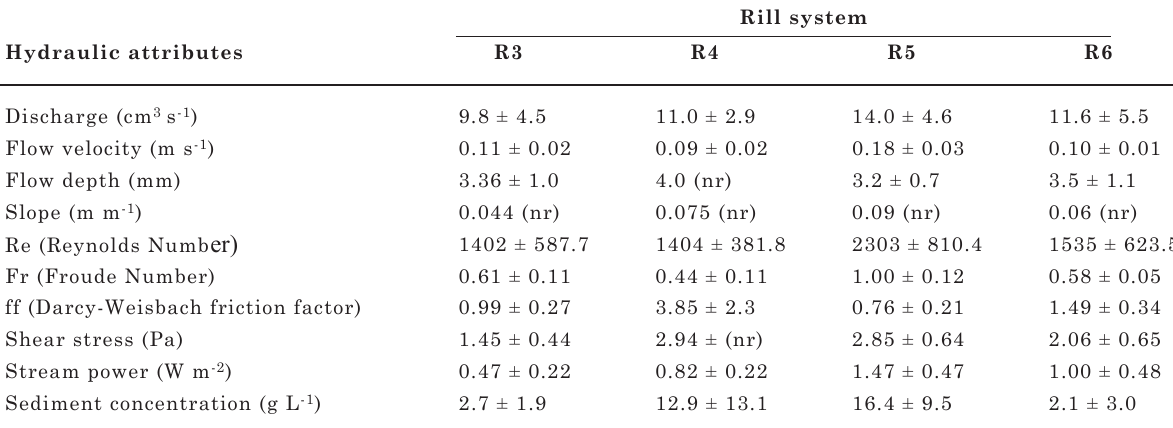
table 4. Summary of the hydraulic attributes and sediment